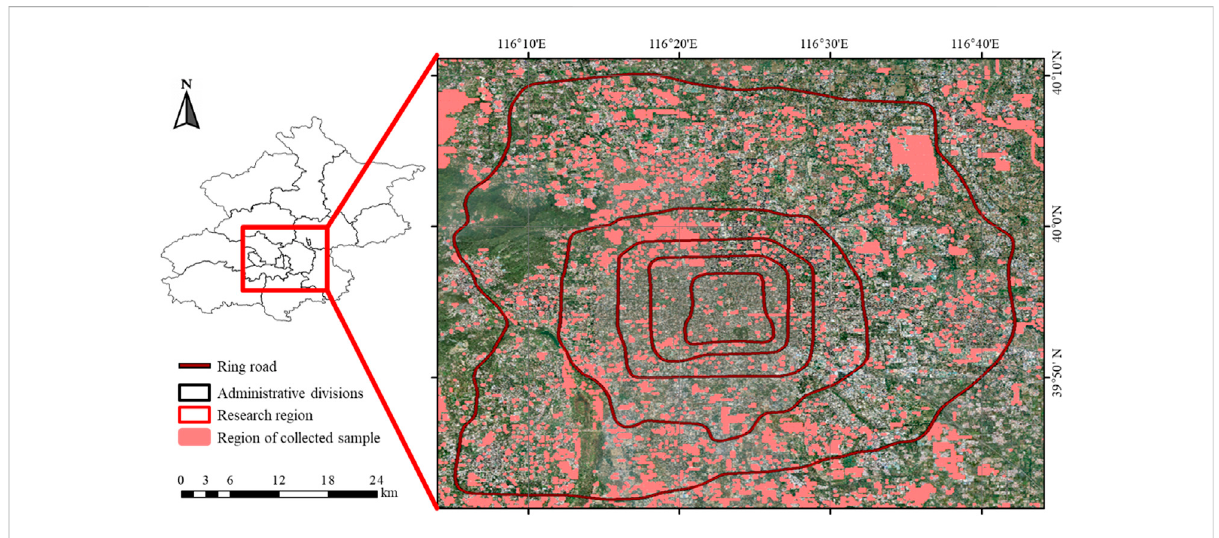
FIGURE 1 The study area and its location in Beijing,